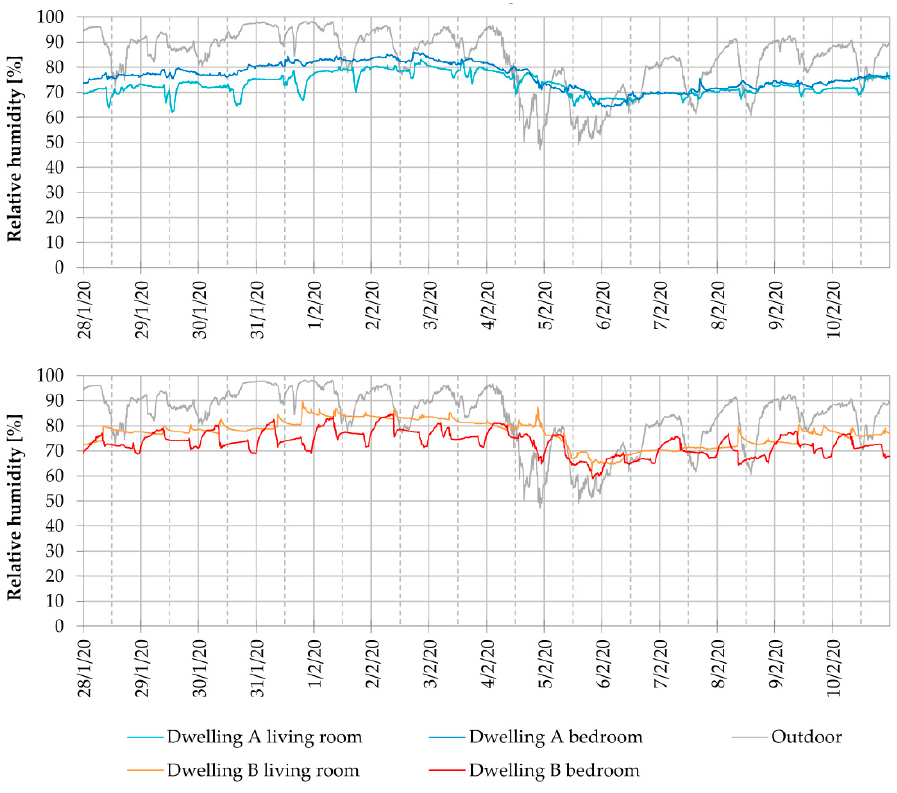
Figure 6. Monitored relative humidity. Table 6. Indoor and outdoor relative humidity statistical variables for the monitored